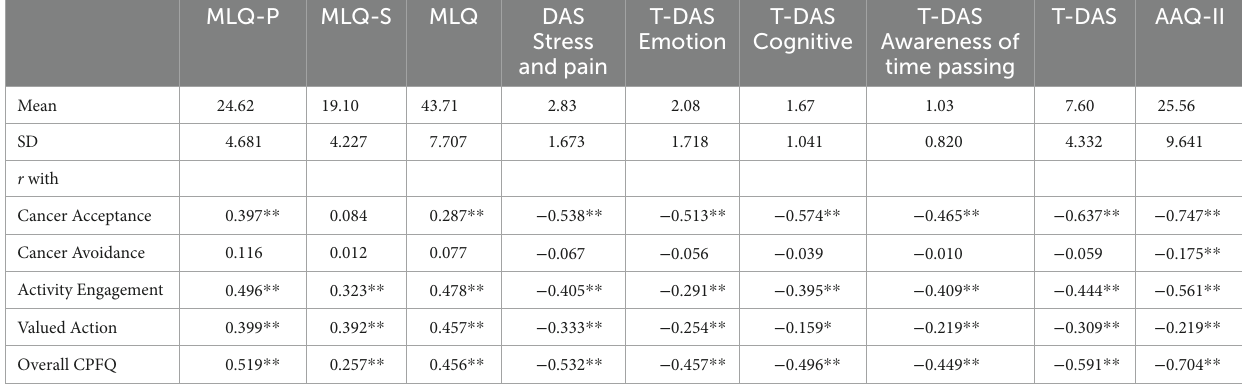
TABLE 2 Means, standardized deviation (SD) of measures, and correlations between overall of CPFQ and its four subscales, two dimensions of MLQ, four dimensions of T-DAS, and